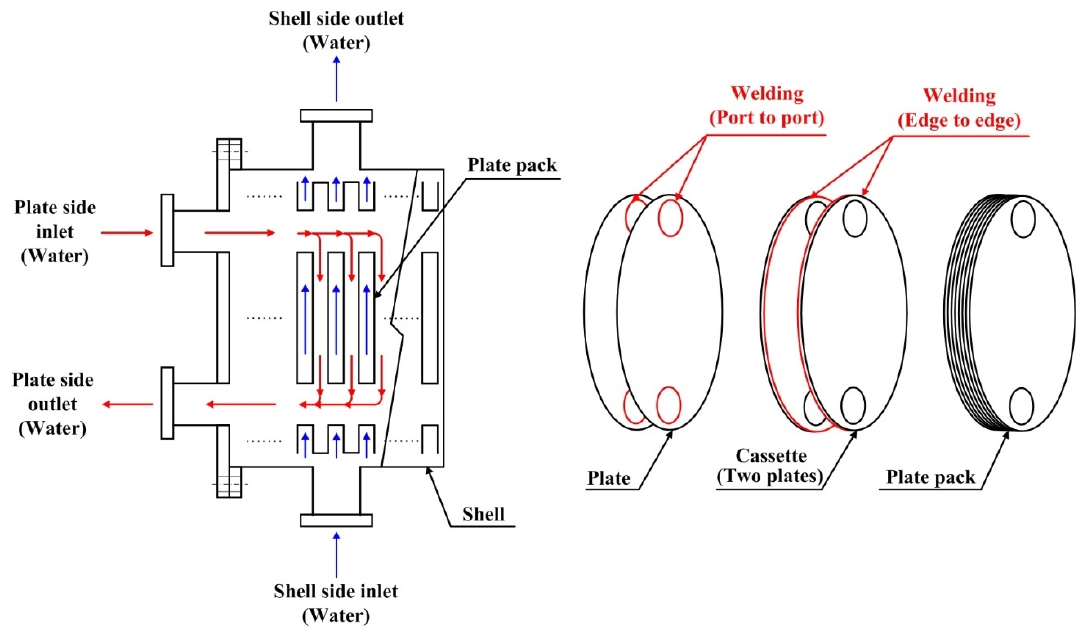
Figure 1. Schematic of the PSHE.